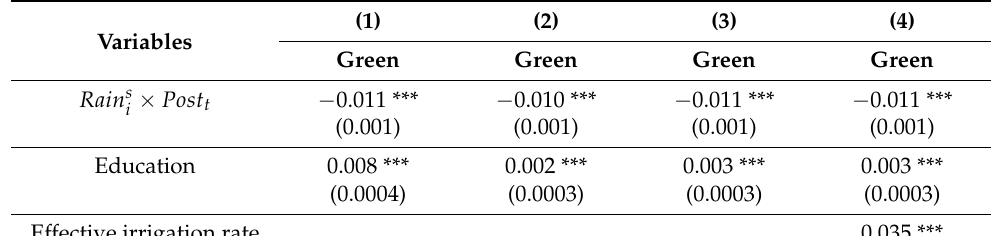
Table A2. Considering the impact of